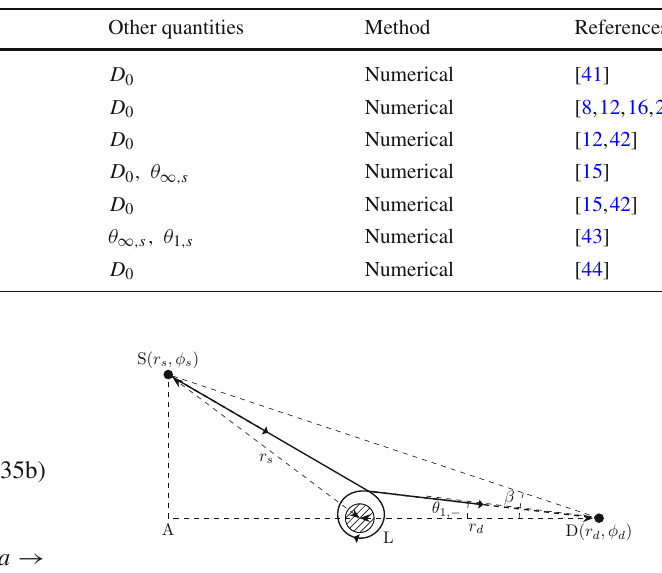
Fig. 1 The GL in the SFL. The trajectory looped one circle clock- wisely. ( r s , φ s ) and ( r d , φ d ) are the locations of the source S and detector D respectively. L is the lens. θ 1 , − is the apparent angle of this particular